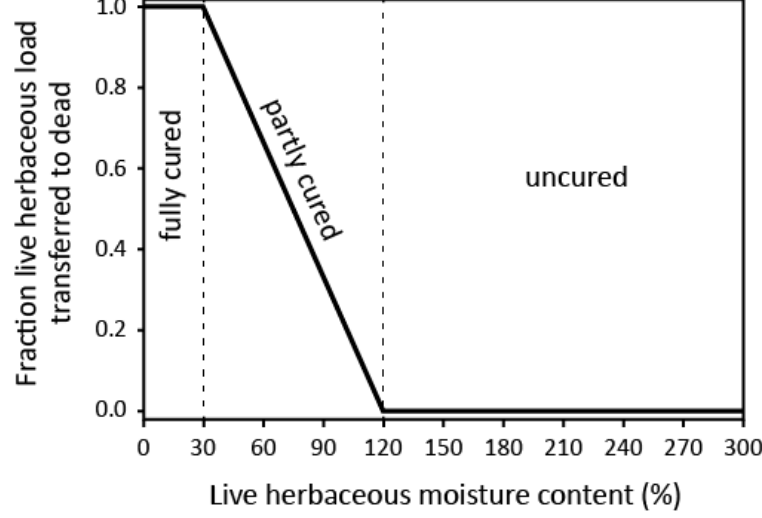
Figure 2. Dynamic fuel model process from Scott and Burgan [47].